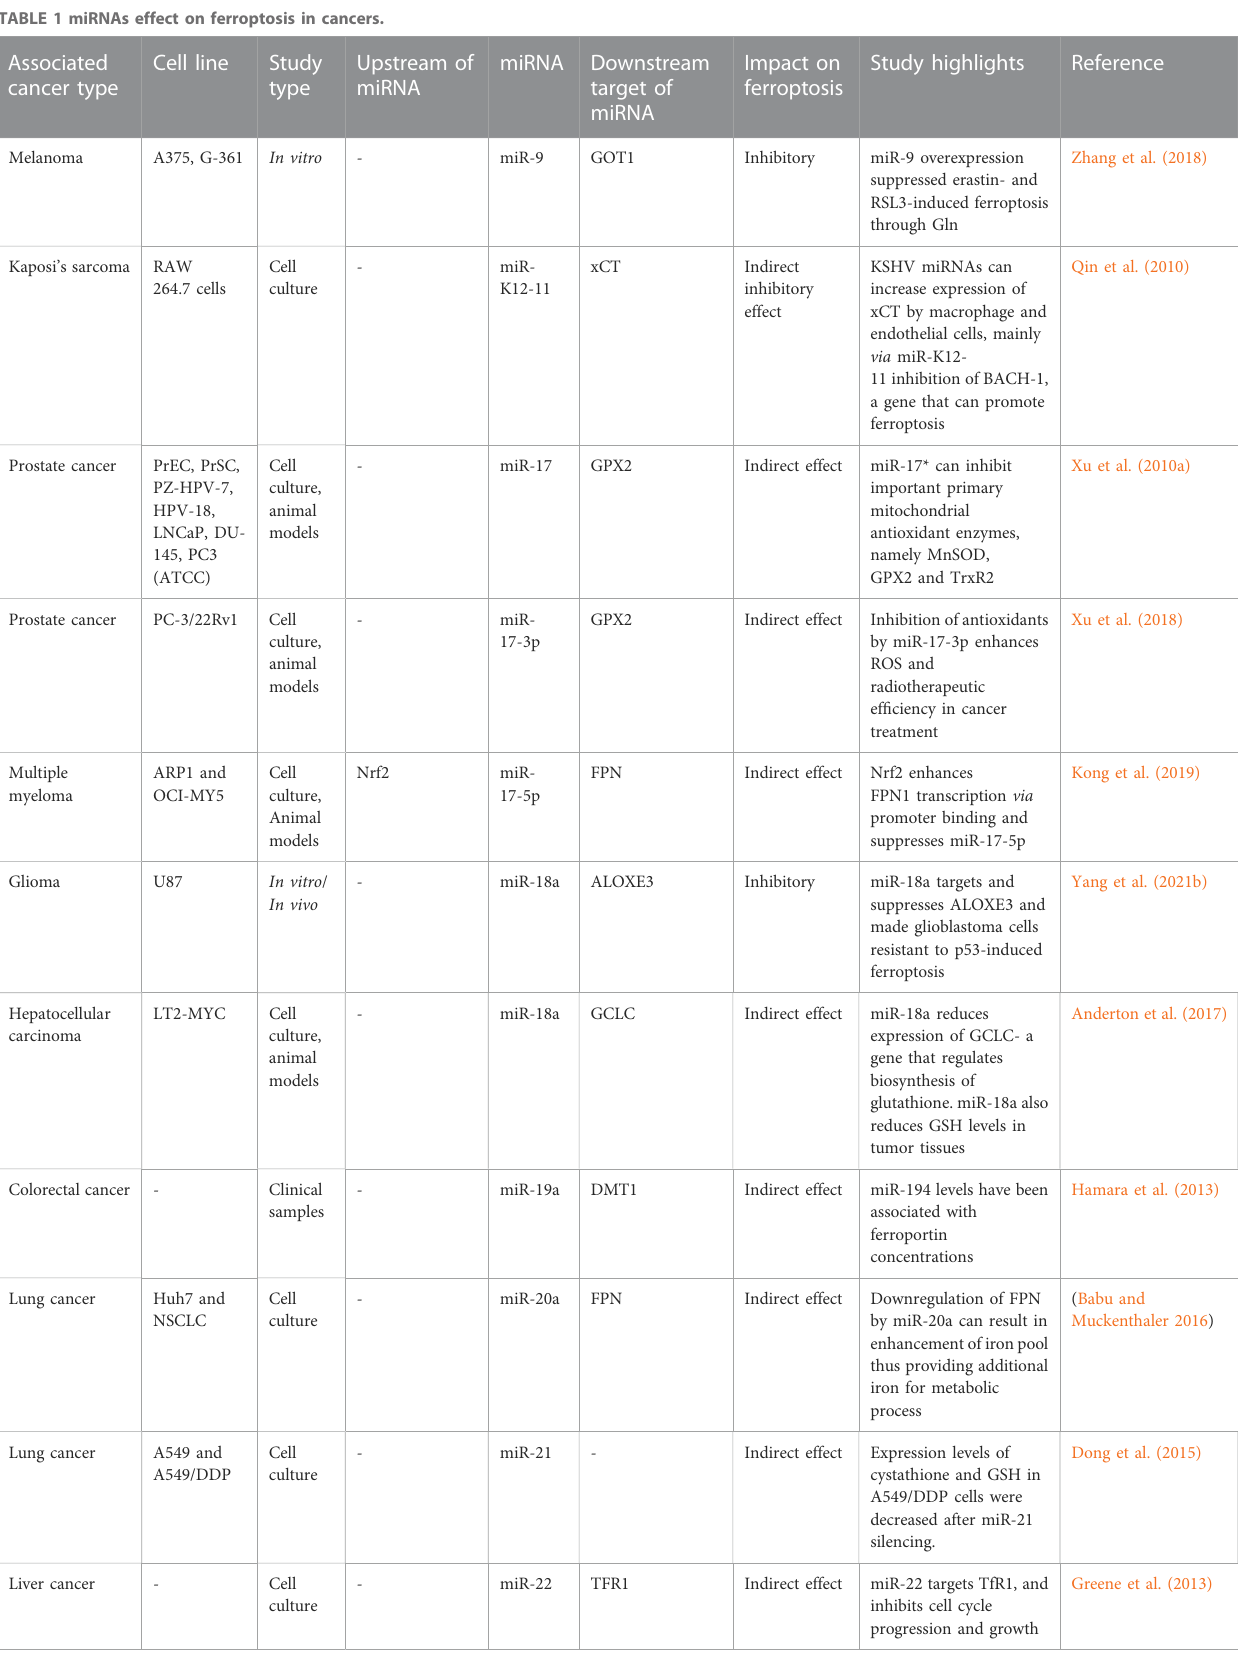
TABLE 1 miRNAs effect on ferroptosis in